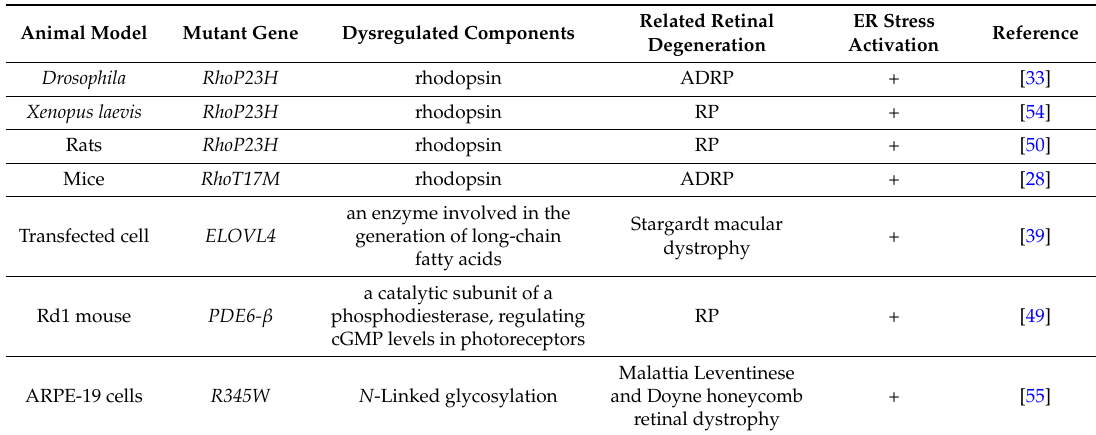
Table 1. Summary of inherited retinal degenerations (IRD) models and dysregulated components. Animal